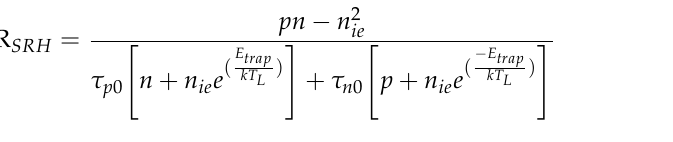
2 O 3 MOSFET with a dual epitaxial